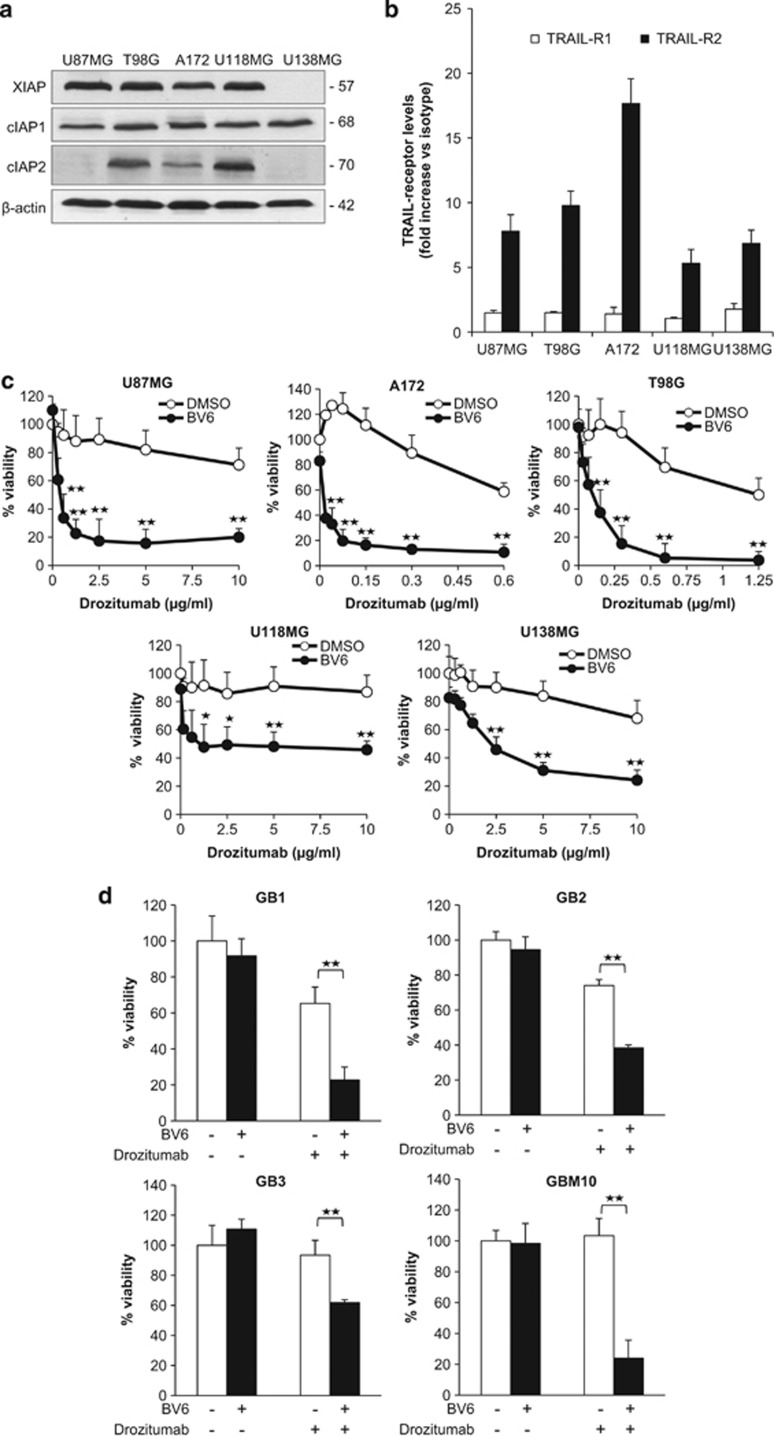
BV6 sensitizes glioblastoma cells to Drozitumab-induced apoptosis. (a) Expression levels of cIAP1, cIAP2 and XIAP were assessed by western blot analysis in glioblastoma cell lines. β-actin was used as loading control. (b) Surface expression of TRAIL-R1 and -R2 on glioblastoma cell lines was determined by flow cytometry. Relative expression levels of TRAIL receptors are shown as fold increase of isotype control. (c) Cells were treated for 72 h with indicated concentrations of Drozitumab and/or BV6 (U87MG: 4 μM; A172, U138MG: 3 μM; T98G: 2 μM; U118MG: 1 μM). Cell viability was determined by MTT assay and is expressed as the percentage of untreated controls; mean + S.E.M. values of three independent experiments performed in triplicate are shown; *P<0.05; **P<0.001. (d) Primary glioblastoma cells (GB1-3) and glioblastoma stem-like cells (GBM10) were treated for 72 h with BV6 and/or Drozitumab (GB1: 8 μM BV6/0.6 μg/ml Drozitumab, GB2: 2 μM BV6/0.6 μg/ml Drozitumab, GB3: 2 μM BV6/2.5 μg/ml Drozitumab, GBM10: 2.5 μM BV6/10 μg/ml Drozitumab). Cell viability was determined by MTT assay and is expressed as the percentage of untreated controls; mean + S.E.M. values of three independent experiments performed in triplicate are shown; **P<0.001. (e) U87MG and T98G cells were treated for 72 h with 5 μg/ml (U87MG) or 0.3 μg/ml (T98G) Drozitumab and/or 4 μM (U87MG) or 2 μM (T98G) BV6 and then seeded as single cells. Colonies were stained with crystal violet after 14 days and were counted under the microscope. One representative experiment of three independent experiments (right panel) and the percentage of colony numbers compared with untreated control are shown (left panel; data represent mean + S.E.M. of three independent experiments (**P<0.001) comparing samples treated with the combination versus control samples). (f) U87MG cells were seeded on the CAM of chicken embryos and treated with 1 μM BV6 and/or 2.5 μg/ml Drozitumab for 2 days. Tumor growth was analyzed using hematoxylin and eosin-stained paraffin sections of the CAM as described in Materials and Methods. Tumor area as percentage of the untreated control group (left panel; mean + S.E.M. of 18 samples per group of three independent experiments; **P<0.001) and representative pictures of hematoxylin and eosin-stained sections of the CAM (right panel; × 4 magnification) are shown. (g) U87MG cells were stereotactically implanted into the brain of nude mice. At days 6 and 9 post implantation of tumor cells 10 μg Drozitumab, 16 nmol BV6, a combination of both compounds or PBS as vehicle were stereotactically injected into tumors. On day 13 post implantation of tumor cells, tumor growth was assessed by MR imaging using a 1 T Icon-Scanner equipped with a mouse brain coil and a T2-weighted image of the brain was acquired. Tumor volumes were determined as described in Materials and Methods. Exemplary MR images are shown in the right panel (scale bar: 1cm) and tumor volumes in the left panel. Mean tumor volume of all animals as percentage of the vehicle group was determined as described in Materials and Methods. At least n=5 animals per group were considered. Mean + S.D. are shown, *P<0.05